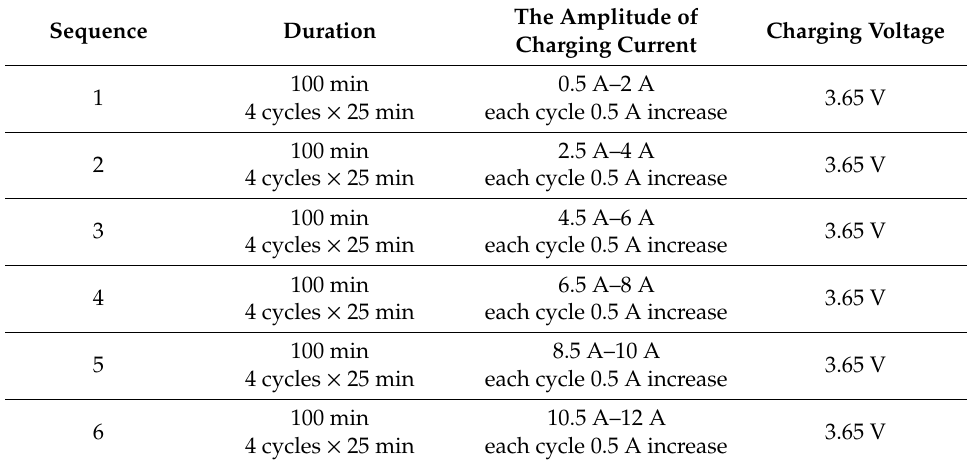
including resting periods of DUT. Figure 10. Time waveform of battery voltage ( left ) and its surface temperature ( right ) during the first